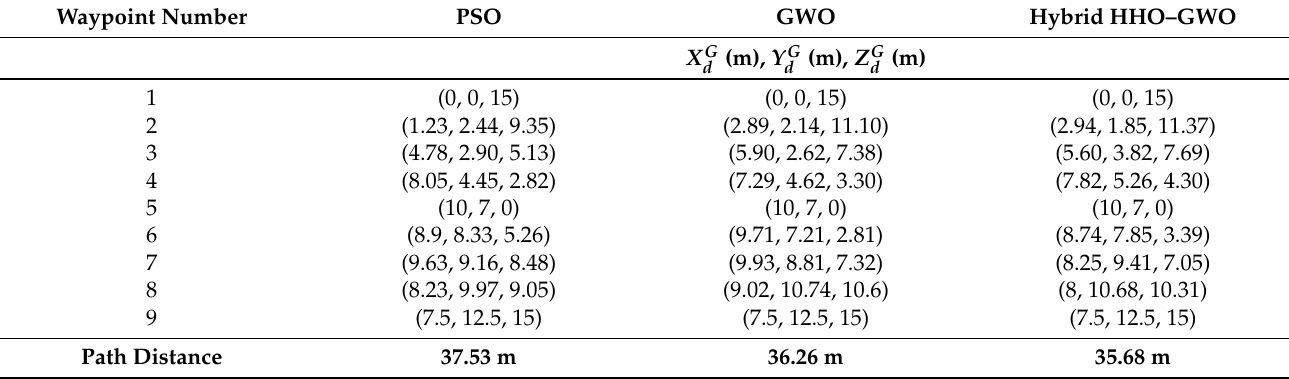
Figure 6. The optimized payload hold ( a ) and release ( b ) path performance of metaheuristic opti- mization algorithms for Map 1. Table 2. Optimized waypoints for Scenario 1.